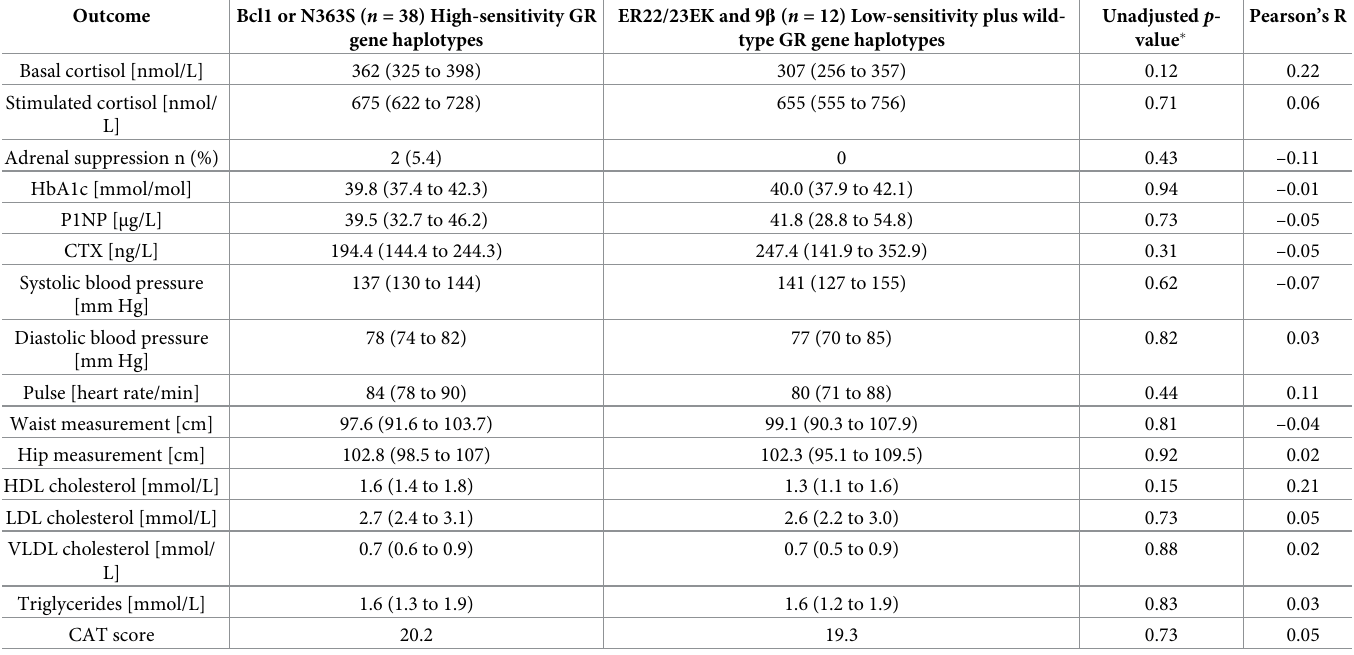
Table 6. Cortisol and Metabolic outcomes in patients with high-sensitivity haplotypes vs. low-sensitivity plus wild-type haplotypes.